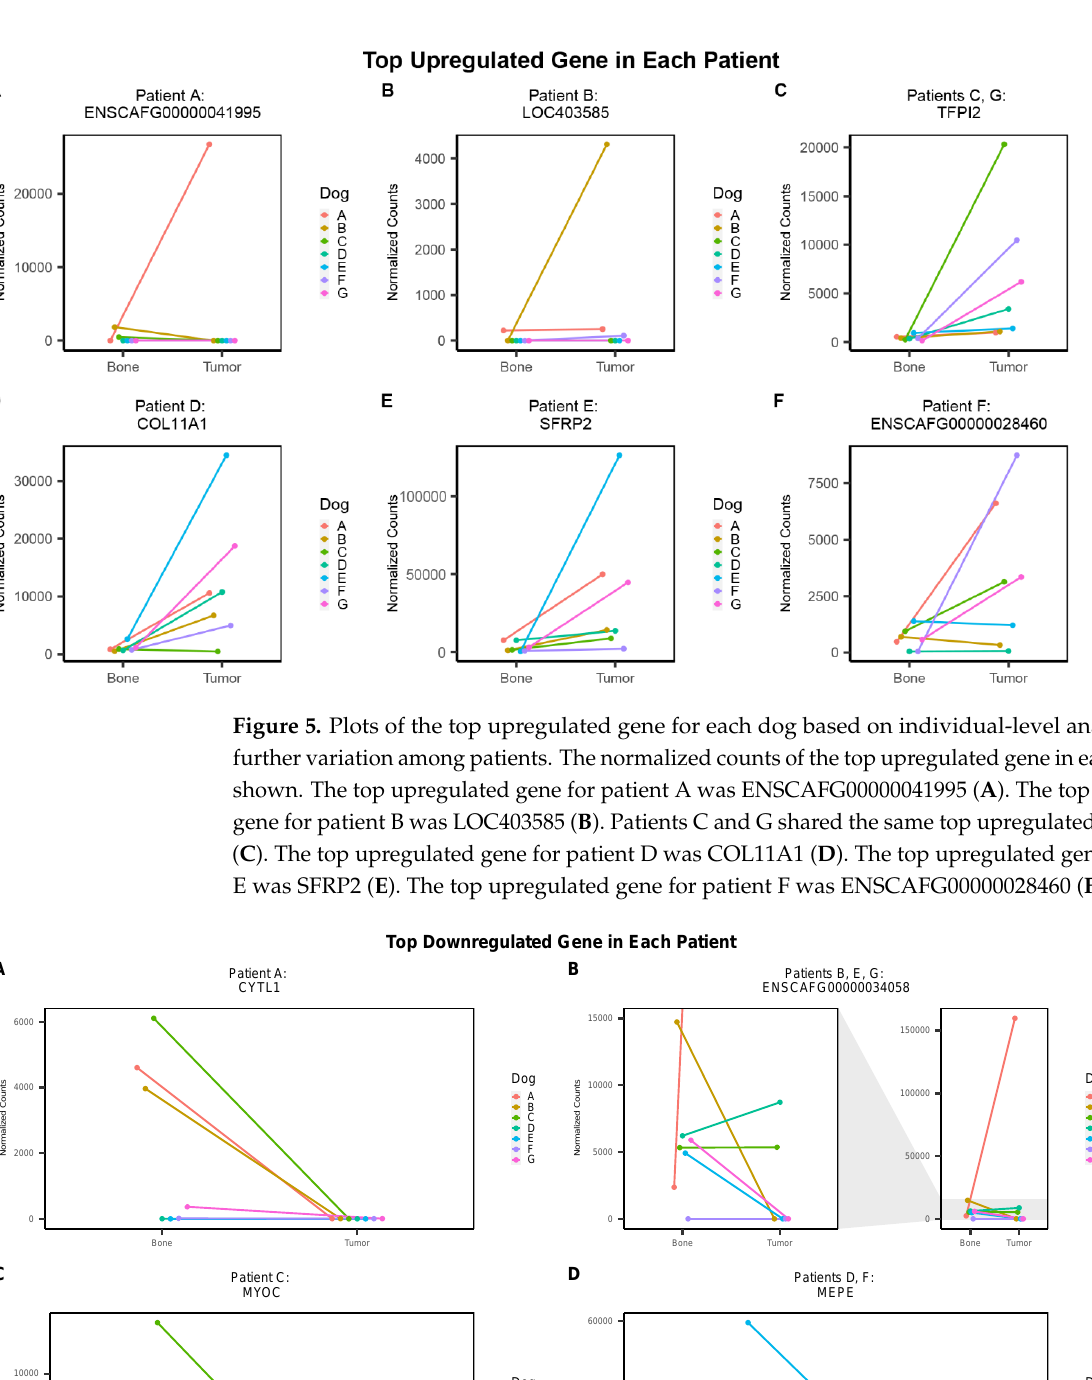
Figure 6. The top downregulated gene for each individual dog is shared among some patients. The normalized counts of the top downregulated gene in each patient are shown. The top downregulated gene in patient A was CYTL1 ( A ). Patients B, E, and G share the same top downregulated gene, ENSCAFG00000034058 ( B ). The top downregulated gene in patient C was MYOC ( C ). Patients D and F share the same top downregulated gene, MEPE ( D